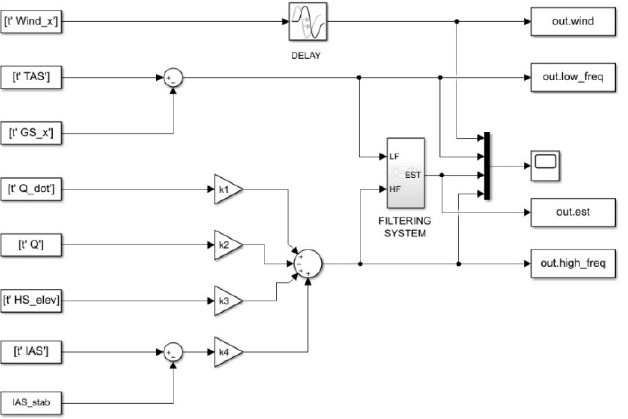
Figure 14. Scheme of system proposed for estimation of the headwind gust.